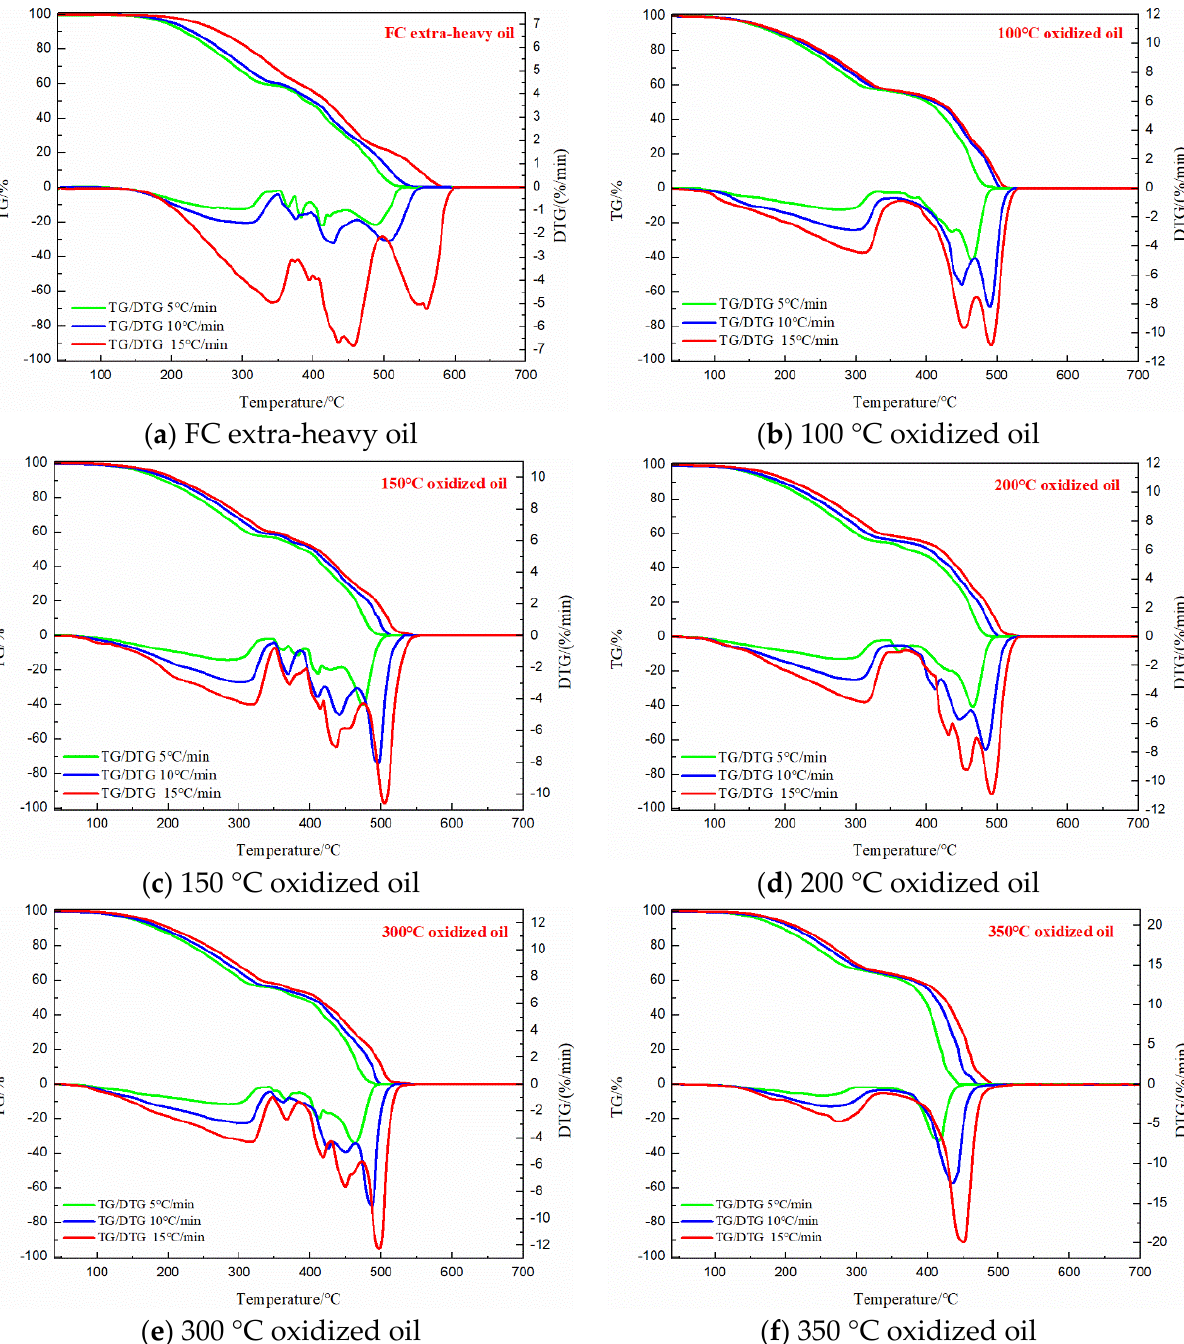
Figure 6. TG/DTG curves of FC extra-heavy oil and each oxidized oil. Table 4. TG/DTG curve parameters of the FC extra-heavy oil and oxidized oils.